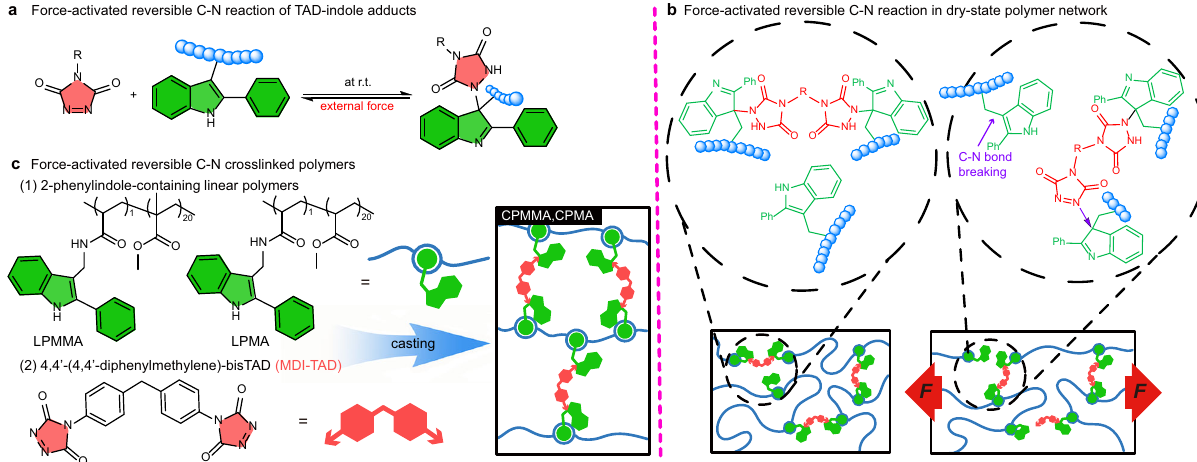
Fig. 1 Monomer and polymer force-reversible TAD-indole chemistry. a Scheme of TAD-indole reversible click reactions at ambient temperature, including a common click reaction and force-reversible reaction. b The breaking and reforming of the force-reversible C-N bond occurs sequentially at ambient temperature in dry-state covalently crosslinked polymers. c TAD-based crosslinker (MDI-TAD) and two different linear indole-containing polymers used in this work to design force-reversible C-N crosslinked amorphous poly(methyl acrylate) (CPMA) and poly(methyl methacrylate) (CPMMA) based